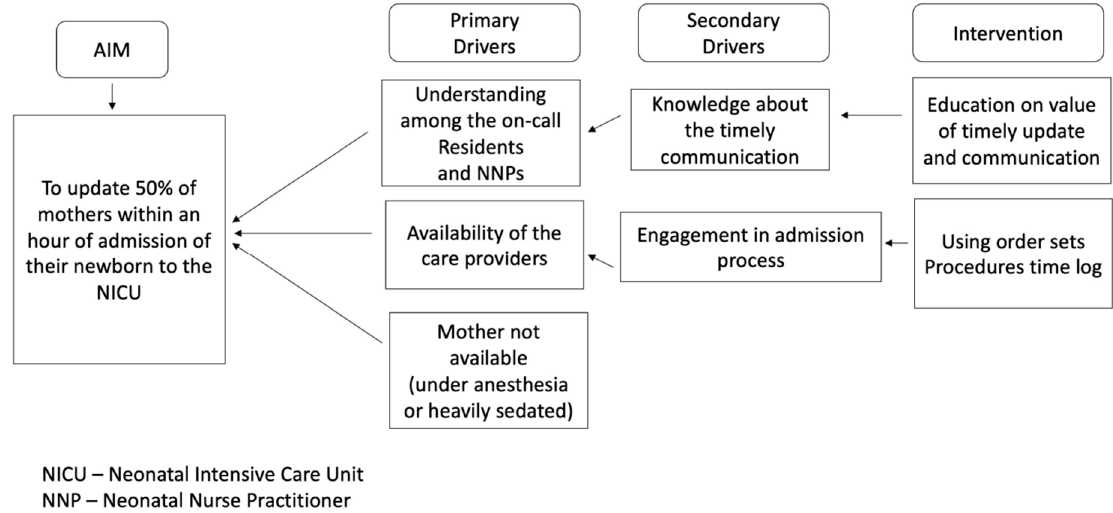
Figure 1. Driver diagram.